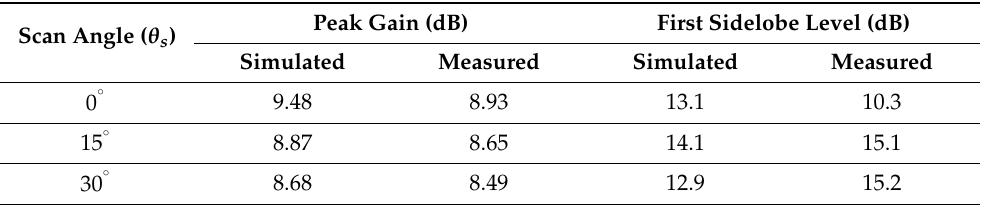
Figure 8. Measured radiation patterns of a 1 × 4 P-CRLH-excited cylindrical phased array: ( a ) broad- side pattern, ( b ) main beam scanning at 15 ◦ , and ( c ) main beam scanning at 30 ◦ . Table 3. Comparison between simulated and measured results of a 1 × 4 P-CRLH-excited cylindrical phased array.